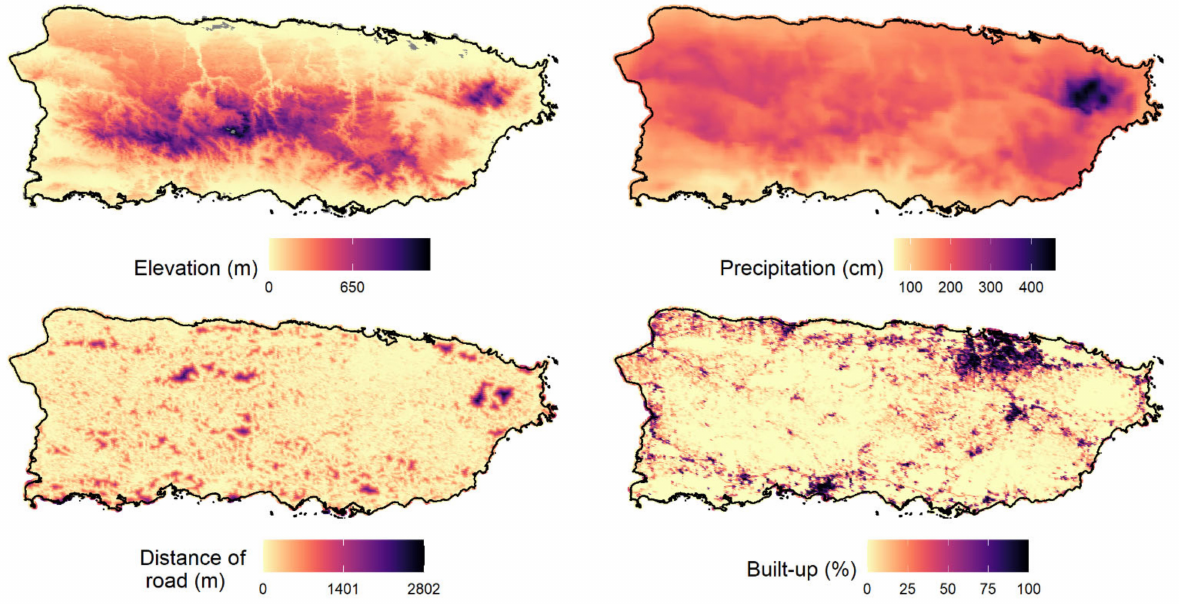
Figure A3. Maps of environmental variables across the main island of Puerto Rico. Top left: elevation (range: 0 to 1325 m); top right: mean annual precipitation (range: 71 to 433 cm); bottom left: distance of nearest road (range: 0.1 to 1864 m); bottom right: built-up proportion (range: 0 to